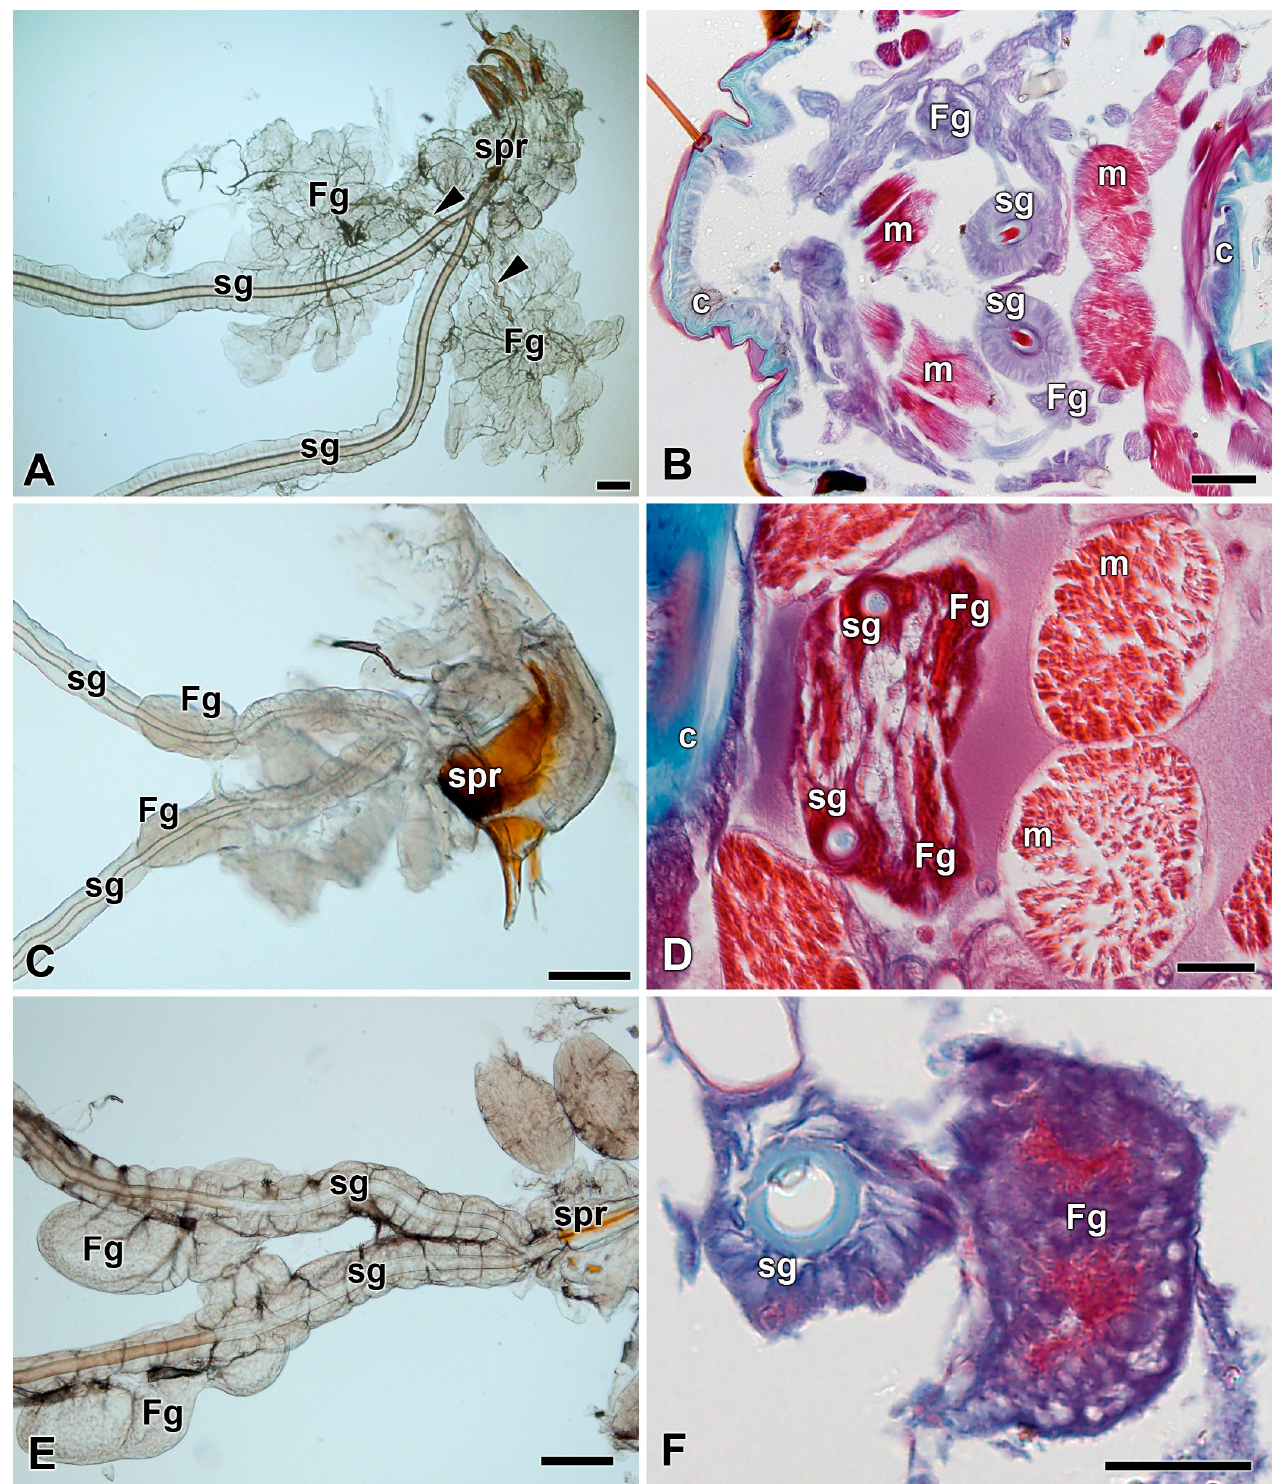
Figure 7. Spinning apparatuses in last instar larvae of the silkworm, Bombyx mori , and Pyralidae. ( A , B ) The silkworm, Bombyx mori . The arrowheads indicate the ducts of the FGs entering the lumen of the SGs. ( C , D ) The Mediterranean flour moth, Ephestia kuehniella . ( E , F ) The greater wax moth, Galleria mellonella. Brightfield images of whole-mount spinning apparatuses are shown in A, C, and E. The cross sections through the spinning apparatuses labeled with Masson trichrome stain in B, D, and F. Abbreviations: Cuticle (c), Filippi’s gland (Fg), muscles of the silk press (m), silk gland (sg), and silk press of the spinning apparatus (spr). Scale bars: A, C, and E, 100 μ m; B, D, and F, 200 μ m.